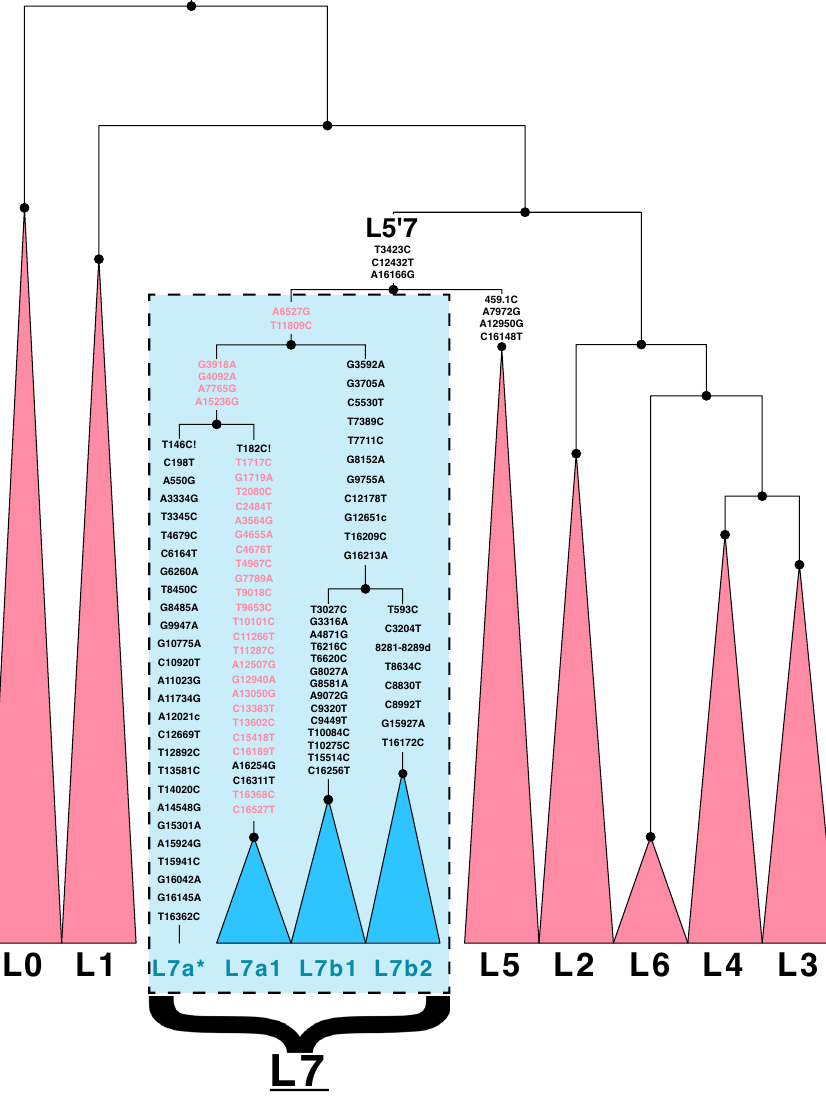
Figure 1. Phylogenetic Placement of New L7 Lineage. Major clades are collapsed, showing the existing (red) and newly discovered (blue) clades. Defining mutations are shown for L5'7, L5, L7, and the six major branches in L7 (L7a, L7a*, L7a1, L7b, L7b1, L7b2). Mutations formerly defining L5b2 that actually define L7 are highlighted in